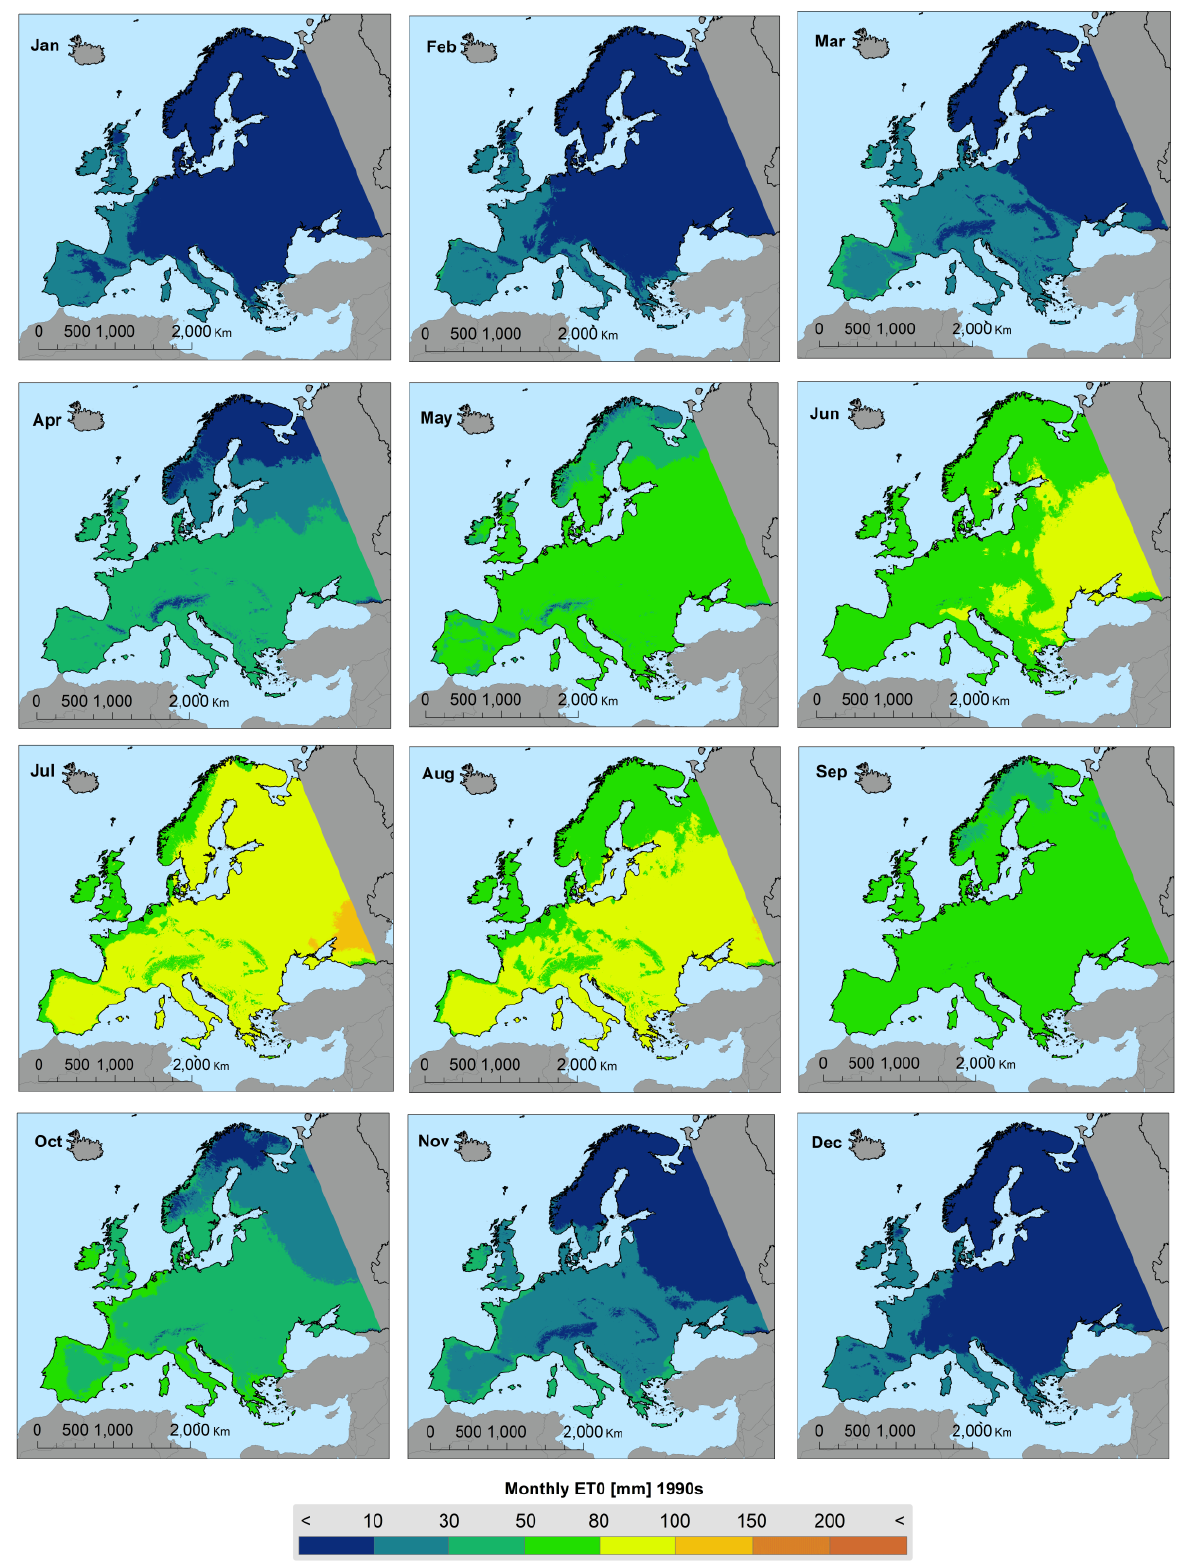
Figure 4. Spatial distribution of monthly ET0 over Europe during 1990s.